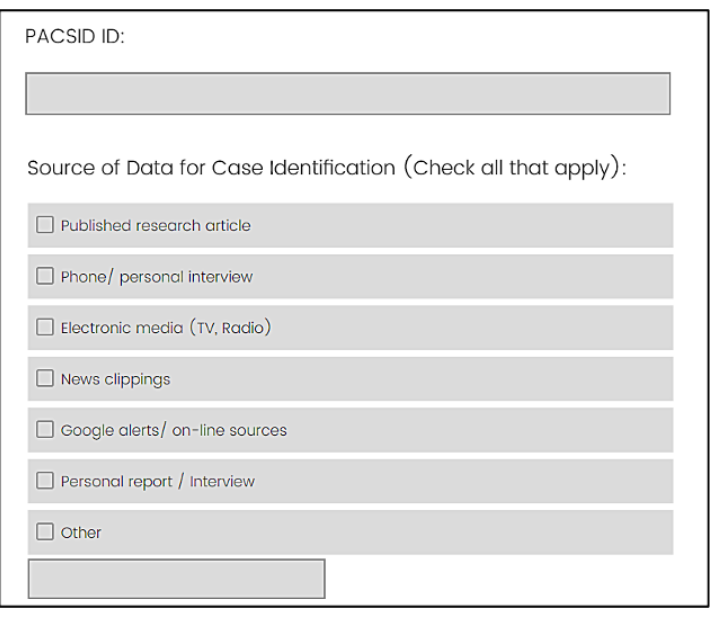
Figure 2. Data input coding form of Qualtrics survey.